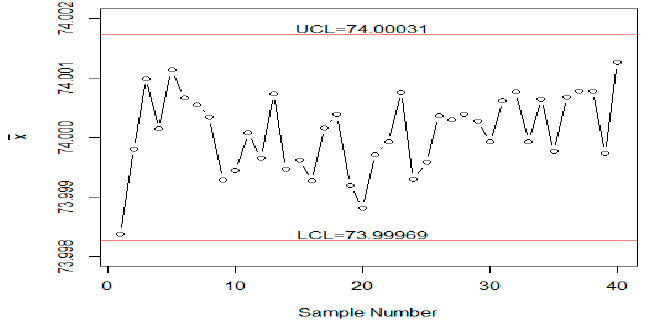
Figure 3. The X-bar chart under classic statistics (CS) for the summated data.